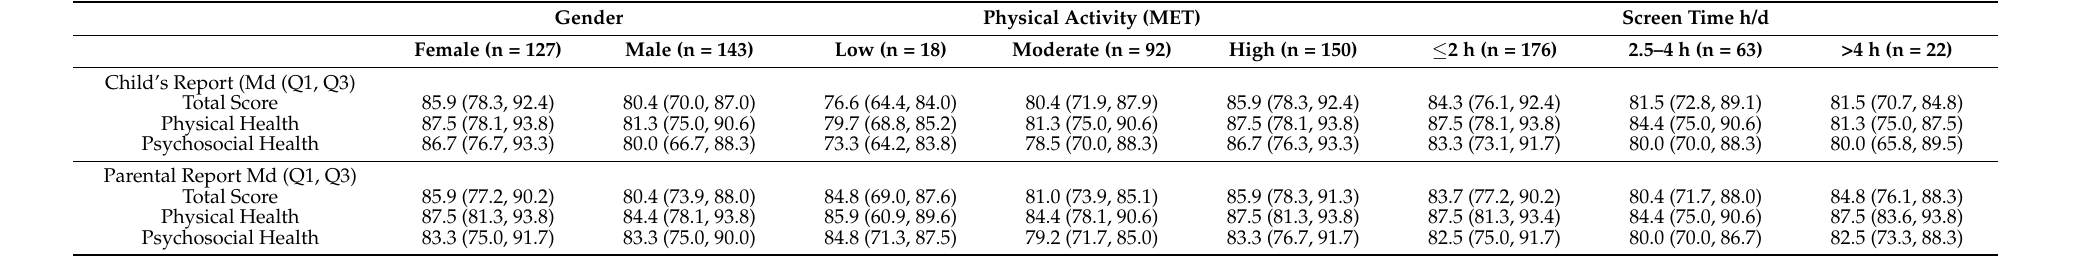
Table 7. Median values (Q1, Q3) for PedsQL total score, physical health, psychosocial health for significant lifestyle